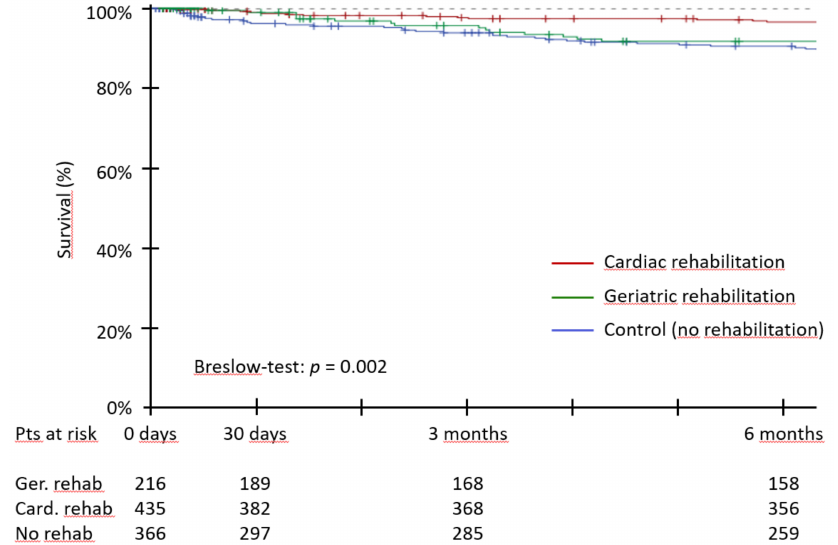
Figure 4. Survival during the first six months after TAVI for patients with cardiac vs. geriatric vs. no rehabilitation. Legend: Kaplan-Meier survival curves for geriatric rehabilitation, cardiac rehabilitation and control (no rehabilitation)